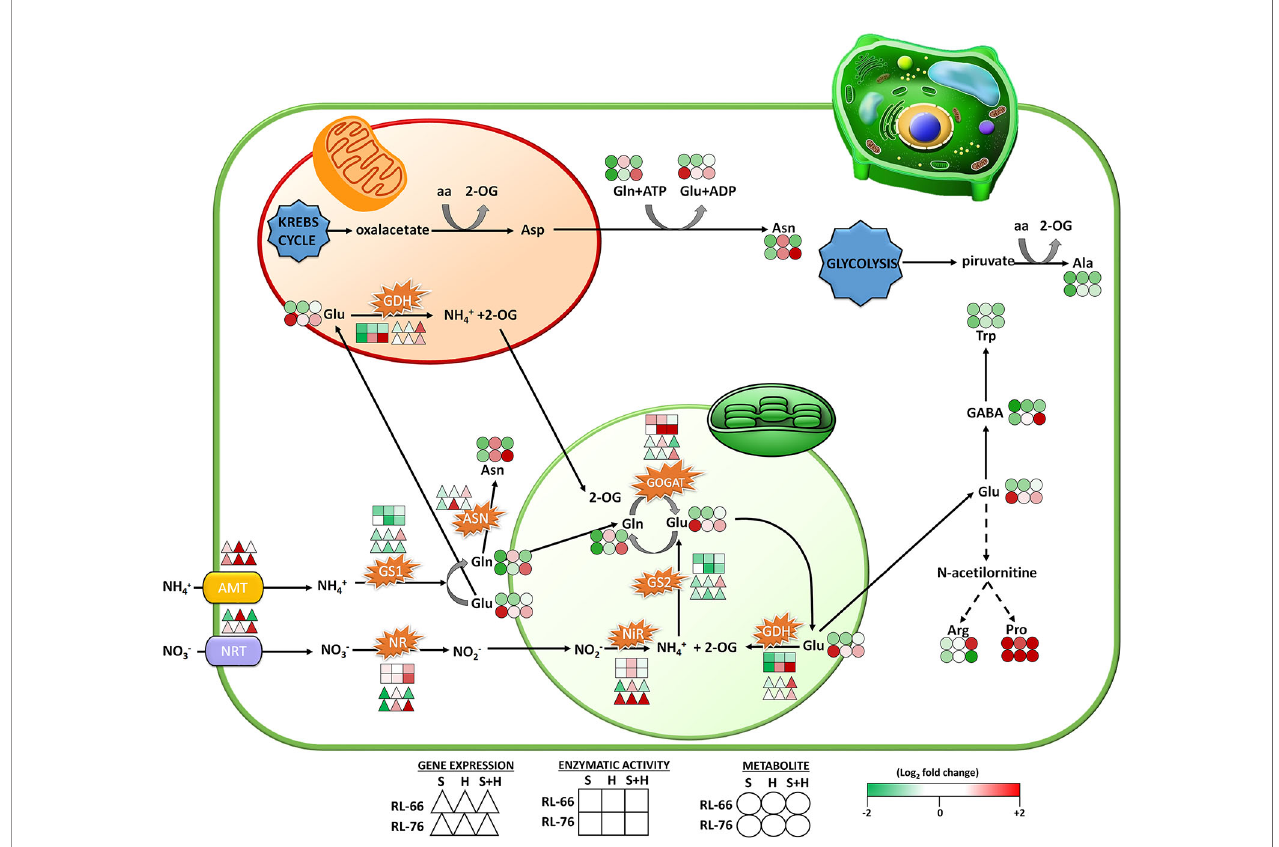
FIGURE 7 | Scheme of the proposed changes occurring in the nitrogen (N)-assimilation pathway. Changes were represented in recombinant inbred line (RIL)-66 (salt+heat sensitive; up row symbols) and RIL-76 (salt+heat tolerant; down row symbols) under salinity, heat, or the combination of salinity and heat at gene ( D ), enzyme ( □ ), and metabolite ( ○ ) levels. Changes are expressed as the log2 of the normalized values against the respective control values obtained in each recombinant line (n =